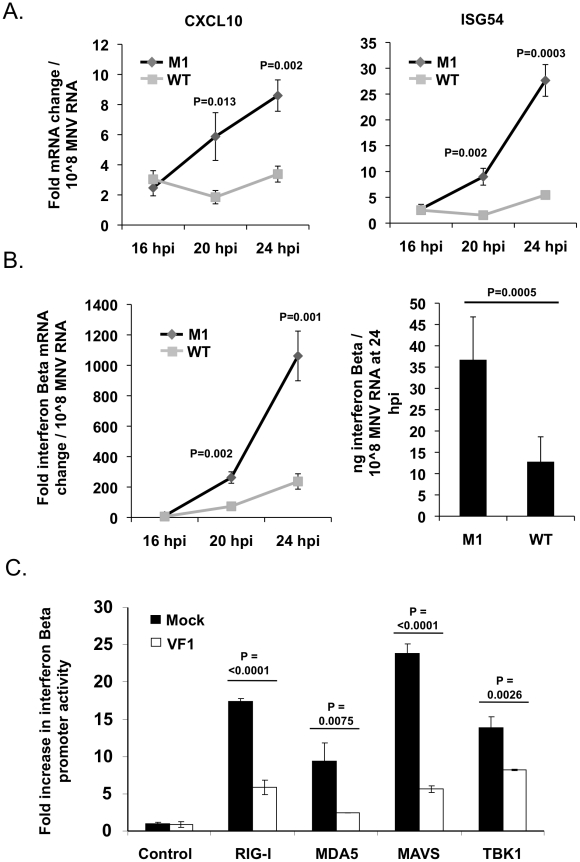
VF1 antagonizes the innate immune response to MNV infection.(A) Time course of ISG54 and CXCL10 mRNA expression in RAW264.7 cells infected at an MOI of 0.1 TCID50 per cell. mRNA levels were quantified by qPCR using an endogenous control gene (Hypoxanthine-guanine phosphoribosyltransferase, HPRT). Expression of the respective mRNAs was then calculated using the ΔΔCt method to compare infected and mock infected cells. Relative fold change was calculated using mock infected samples taken at comparable time points. Normalization was performed following MNV quantification in each sample. Infections were carried out in triplicate with each sample being subsequently analyzed in duplicate by qPCR. The error bars denote standard deviation from the mean. Statistical analysis was performed using an unpaired two tailed t test. (B) Time course of IFN-Beta mRNA and protein production in RAW264.7 cells infected as in (A). mRNA upregulation was calculated as described for (A). Interferon Beta protein was quantified by murine IFN-B specific ELISA at 24 hpi from supernatant samples taken from infected cells. For the ELISA infections were carried out in sextuplate. The error bars denote standard deviation from the mean. (C) MEF cells transfected with an IFN-Beta promoter driven luciferase reporter as well as expression constructs for RIG1, MDA5, MAVS or TBK1 were co-transfected with plasmid DNA expressing VF1 or blank message. Luciferase production was assayed 24 hours post transfection as described in the Materials and Methods. Transfections were carried out in triplicate. The error bars denote standard deviation from the mean. Statistical analysis was performed using an unpaired two tailed t test.